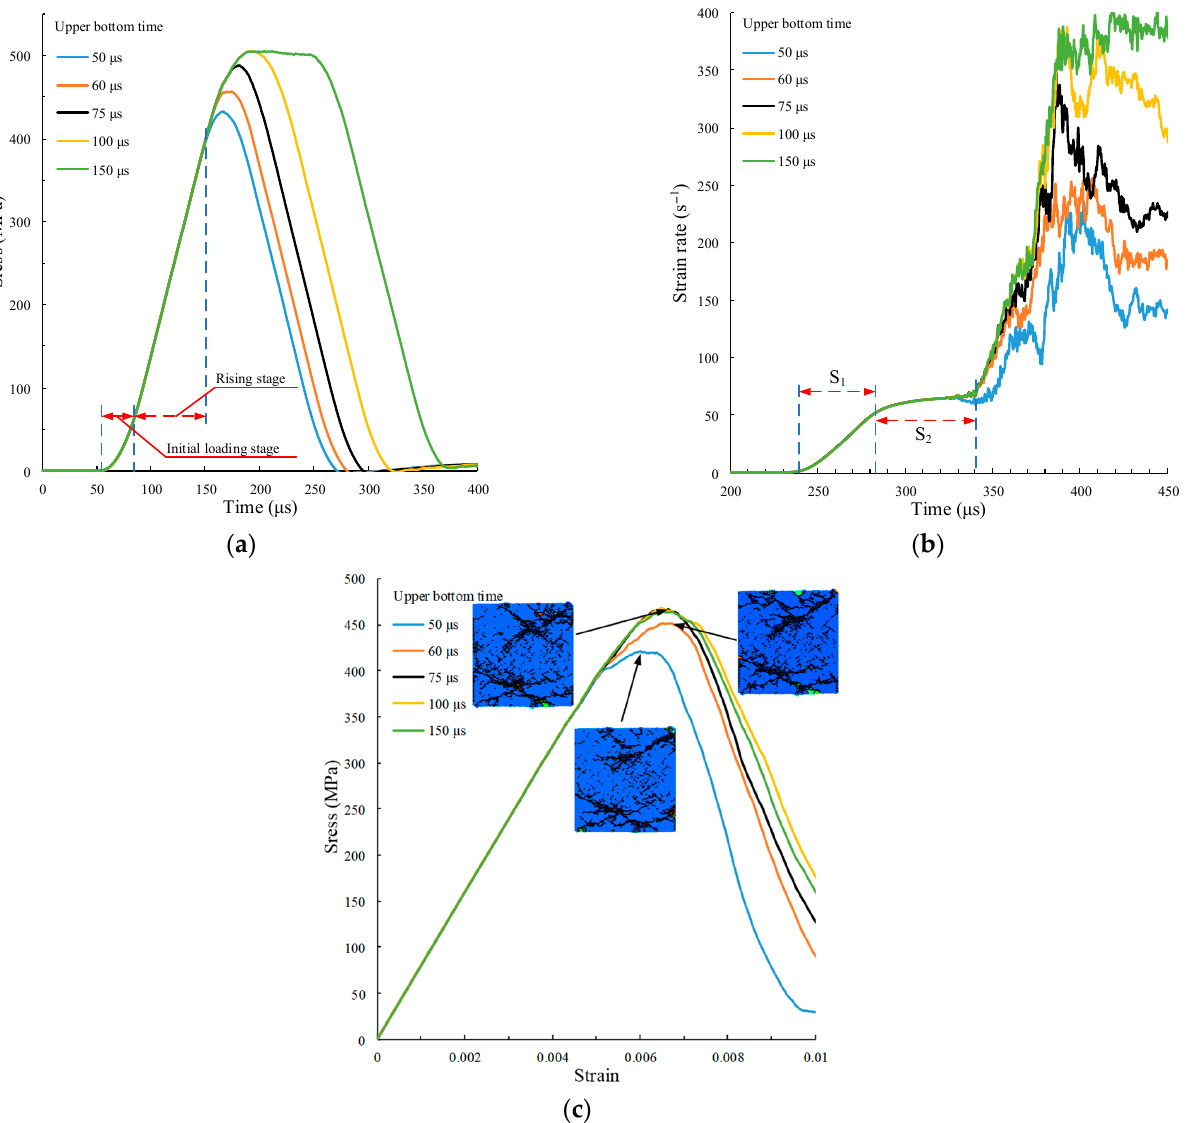
Figure 13. Curve calculations under different upper bottom times. ( a ) Time history curves of incident stress wave; ( b ) time history curves of strain rate; ( c ) stress–strain curve.